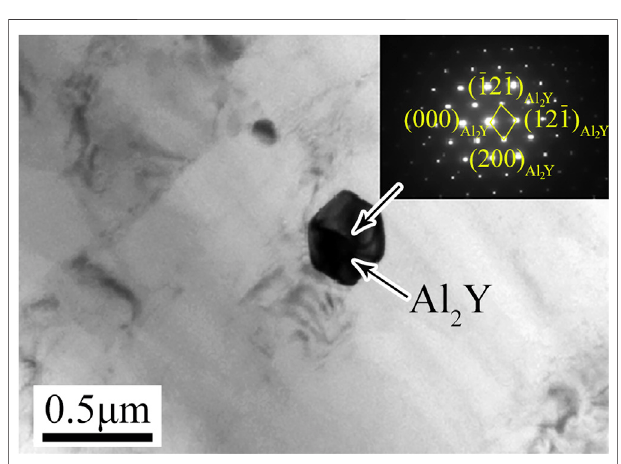
FIGURE 4 | TEM BF image of the Al 2 Y in the LAY410 alloy and its SAED pattern (inset).